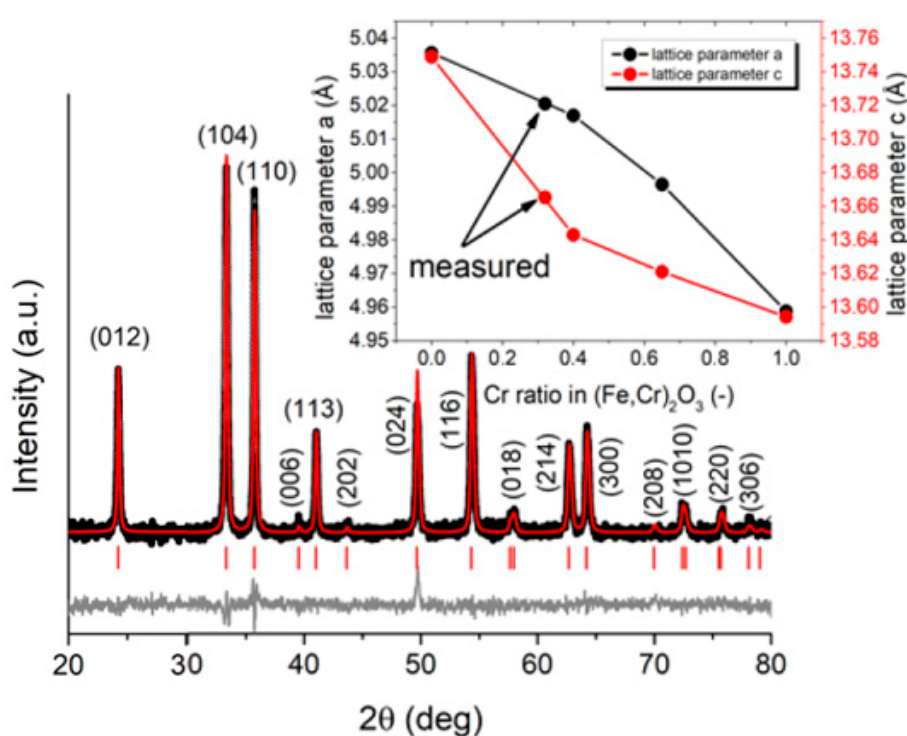
Figure 9. XRD spectrum of EC solid product prepared from leachate of HC FeCr refined for lattice parameter determination of (Fe,Cr) 2 O 3 phase. The insert graph shows the place of fitted values between known parameters from PDF2 database.